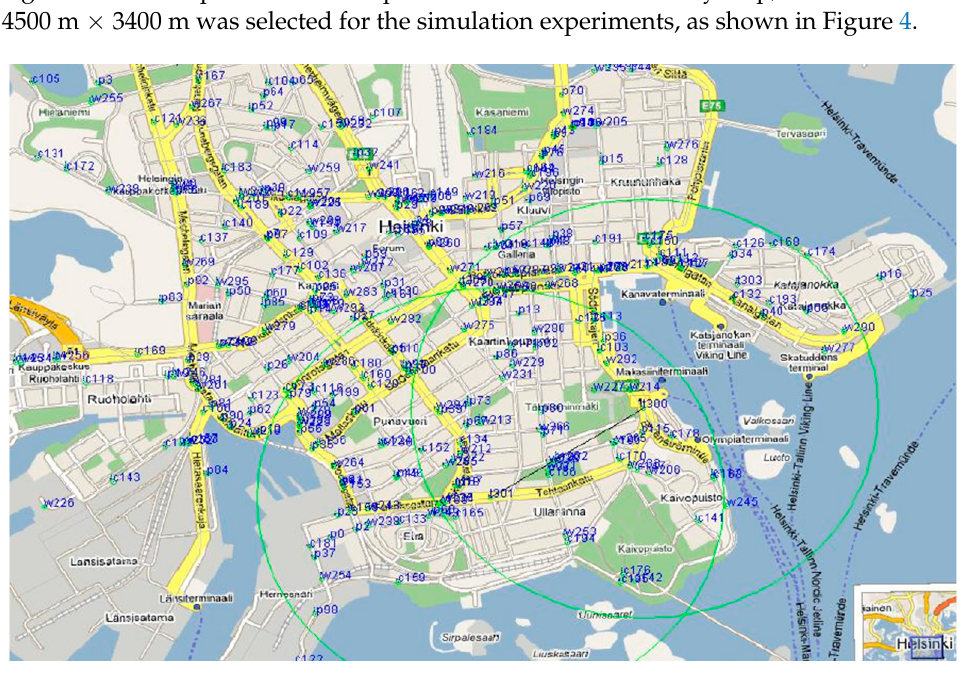
Figure 4. City map of Helsinki, Finland.